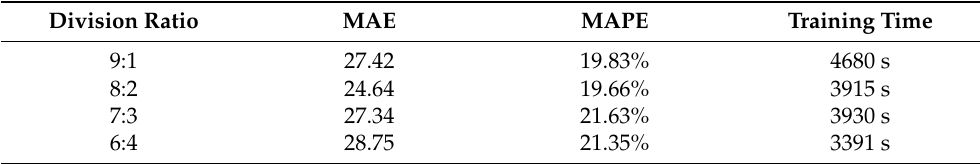
Table 3. Evaluation of model performance with different data division ratio with lstmunits set to 128 and epochs set to 20.